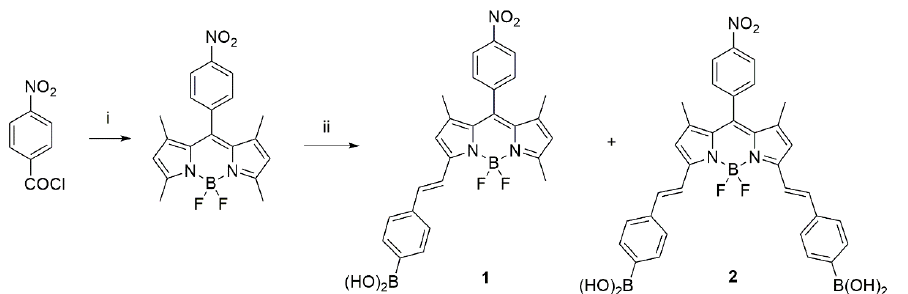
Figure 3. Synthetic route for monostyryl boronic acid-BODIPY 1 and distyryl boronic acid BODIPY 2 : ( i ) 1. 2,4-dimethylpyrrole, dichloromethane anhydrous, argon, r.t., 2. triethylamine, 3. boron trifluoride diethyl etherate. ( ii ) 4-formylphenylboronic acid, piperidine, acetic acid, toluene anhydrous, MW 900W, reflux, 6 h.